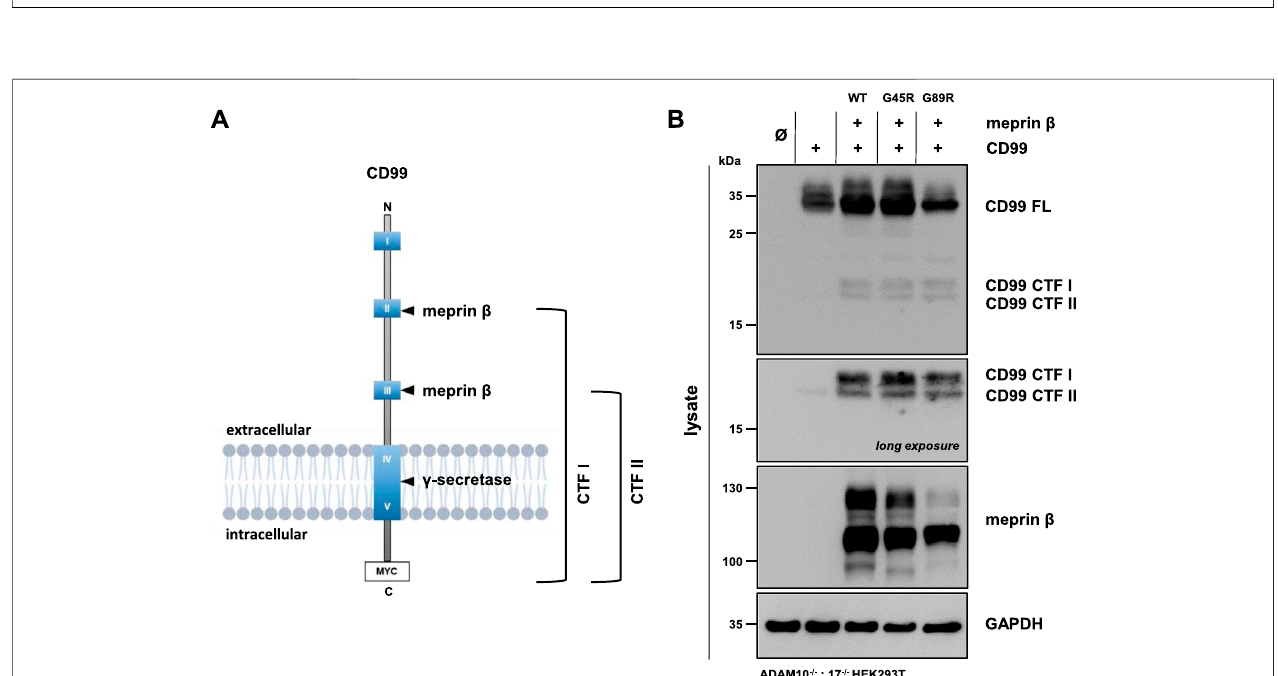
FIGURE4| CD99sheddingbythemeprin β variantsG45RandG89R. (A) CD99constructusedinthisexperiment,highlightingthehighlyconservedacidicregions (HCRs)asblueboxeswithromannumerals,thetwoknowncleavagesitesofmeprin β andtheC-terminalMyc-tag. (B) ADAM10 − / − ;17 − / − HEK293Tcellsweretransiently transfectedwithacontrolplasmid(Ø),CD99alone,andtogetherwithoneoftheindicatedmeprin β variants.CelllysateswereanalyzedbyWesternblottingusingananti- Flag antibody for meprin β and an anti-Myc antibody for CD99 detection (CD99 FL: CD99 full length; CD99 CTF I and CTF II: CD99 C-terminal fragments I and II). GAPDH served as the loading control. To determine the accumulation of γ -secretase – dependent cleavage products, the speci fi c inhibitor DAPT was applied. Western blot quanti fi cation of generated CD99 CTFs from three biologic replicates is presented in Supplementary Figure S3 .